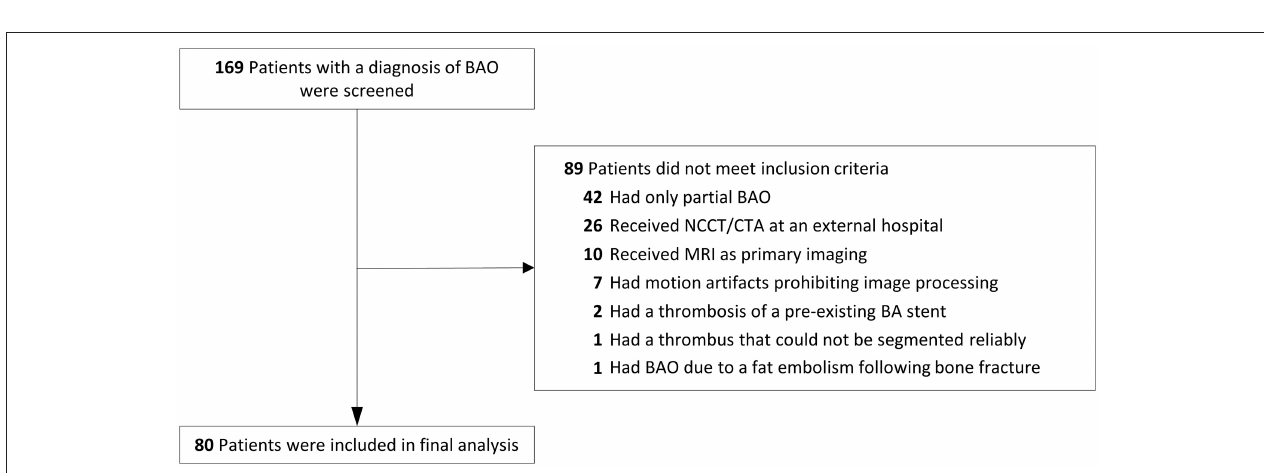
FIGURE 2 | Flowchart. BA, basilar artery; BAO, basilar artery occlusion; NCCT, non-contrast computed tomography; CTA, computed tomography angiography; MRI, magnetic resonance imaging.